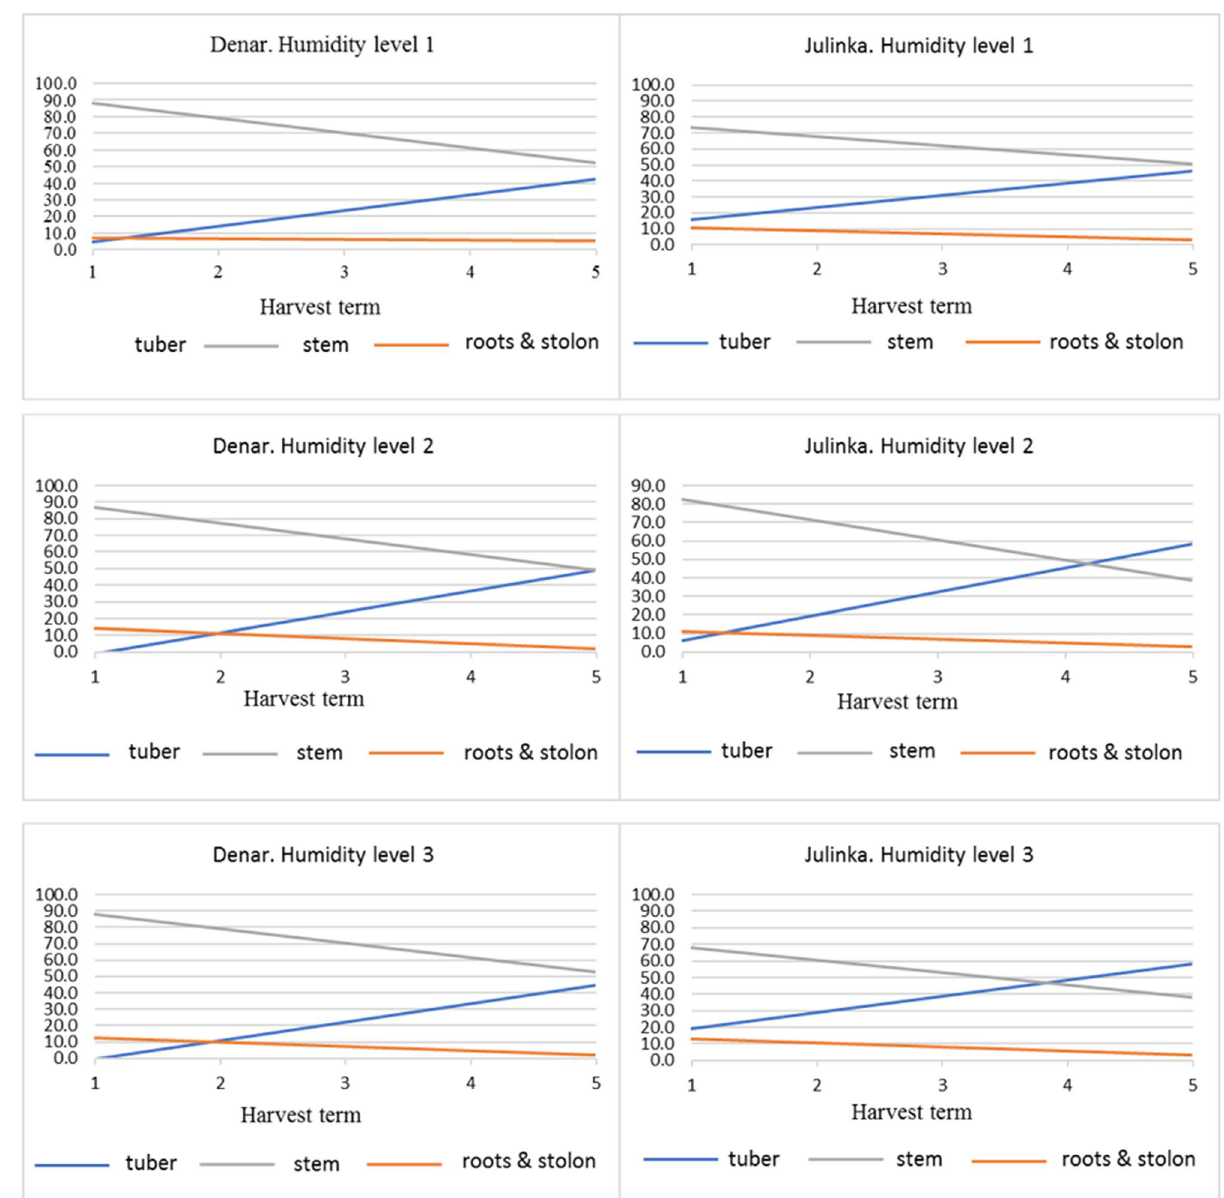
Figure 3. Potato biomass structure changes depending on humidity level and tuber harvest term